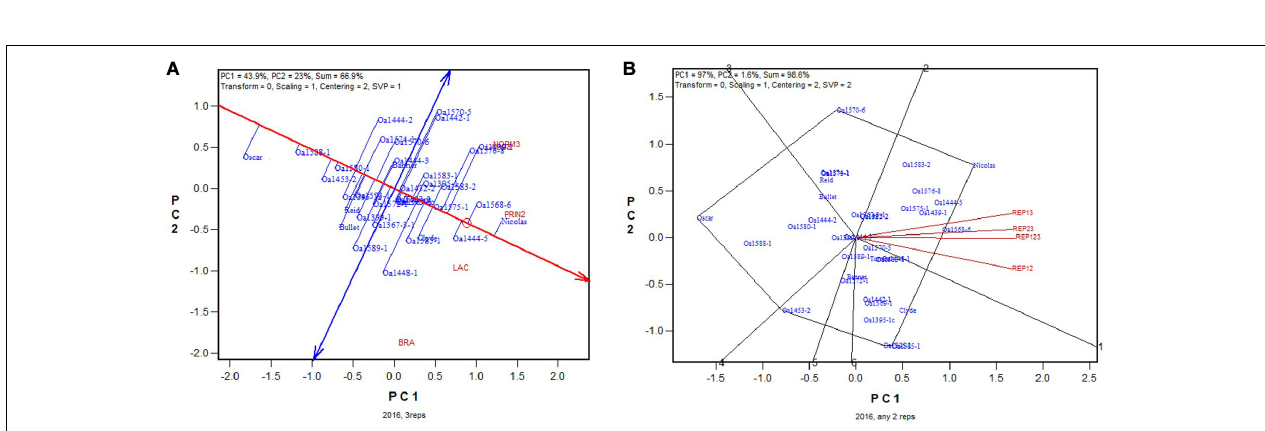
FIGURE 8 | Biplots for the 2015 non-Ontario trials. (A) GGE biplot to show genotype ranking based on data from all three replicates, and (B) summary biplot to show the genotype rankings based on all three replicates and on any two of them. REP123, genotypic ranking based on all three replicates; REP12, genotype ranking based on replicates 1 and 2; REP13, genotype ranking based on replicates 1 and 3.